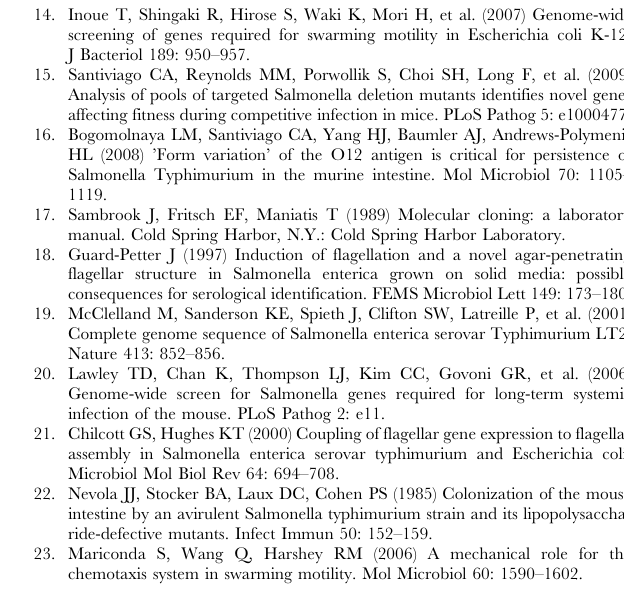
Figure S2 Flagellin expression on the cell surface correlates with the ability to move on swimming and swarming agar for some, but not all mutants. Flagellins sheared from the bacterial surface from strains with decreased (A) or increased (B, C) motility grown in LB-broth were analyzed by Western blotting with m -FliC and m -FljB sera. The whole cell lysates for each sample were also analyzed by SDS-PAGE and stained with Coomassie as a loading control.